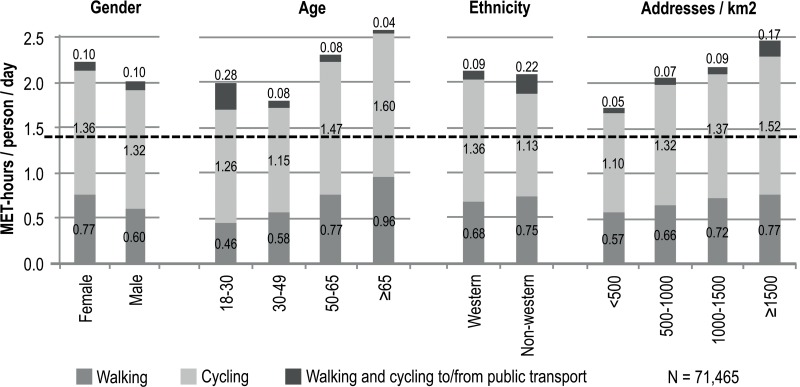
MET-hours gained from daily active transport for different population categories and spatial contexts.NB: Dashed line represents the minimum recommended level of PA.